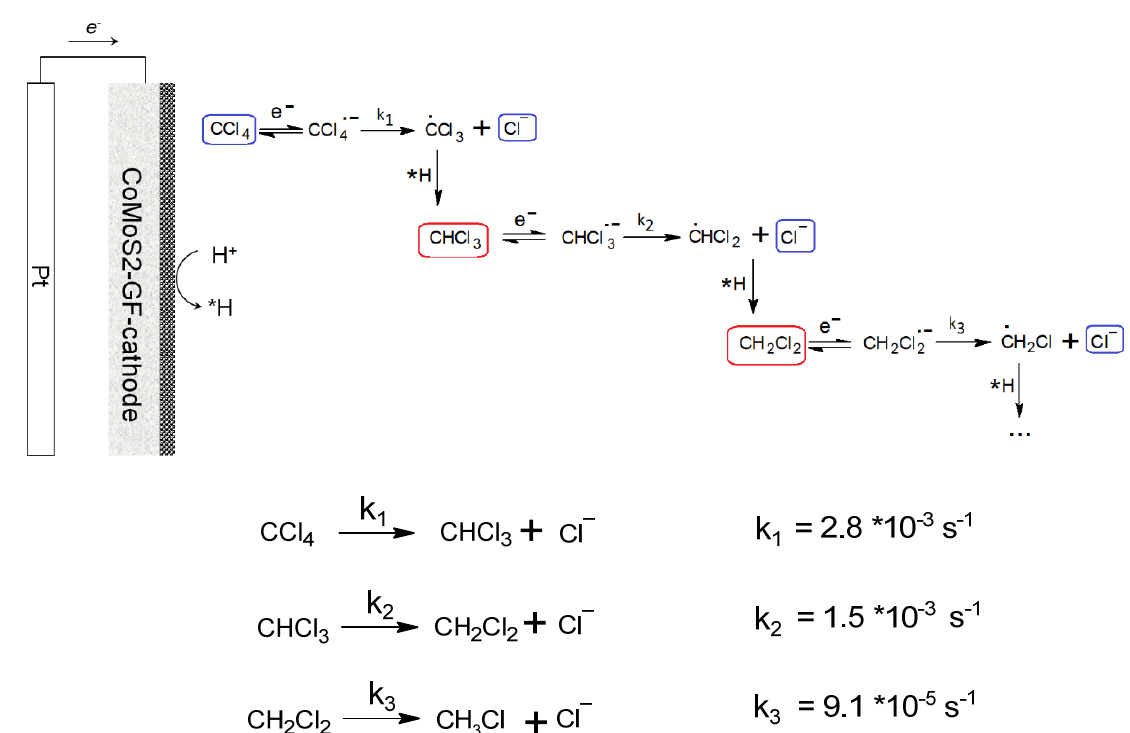
Figure 6. Schematic representation of the electrocatalytic reduction of organohalides at Co-MoS 2 /graphite felt electrode and rate constants for each dechlorination step.